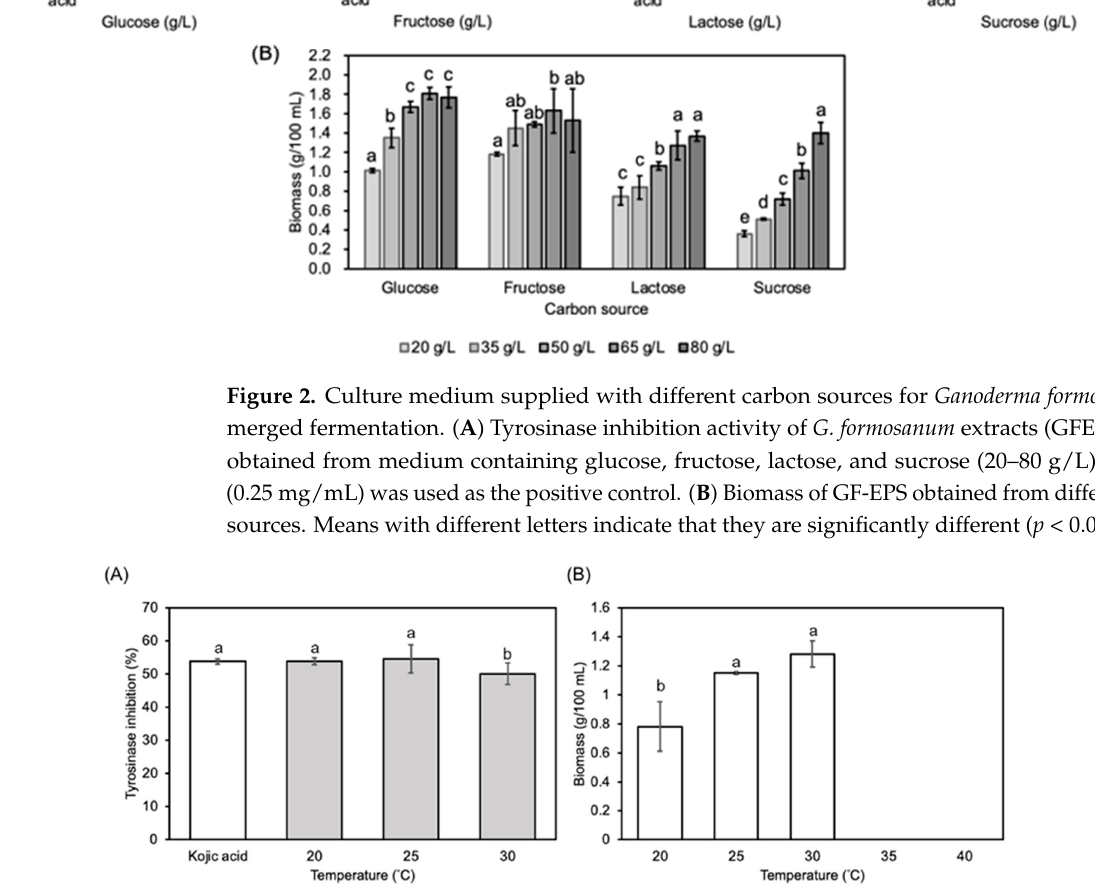
Figure 3. Investigation of tyrosinase inhibition activity from Ganoderma formosanum at different temperatures. ( A ) Tyrosinase inhibition activity of G. formosanum extracts (GFE; 1 mg/mL) at different culture temperatures. Kojic acid (0.25 mg/mL) was used as a positive control. ( B ) Biomass of GF-EPS from different carbon sources. Means with different letters indicate that they are significantly different ( p < 0.05).